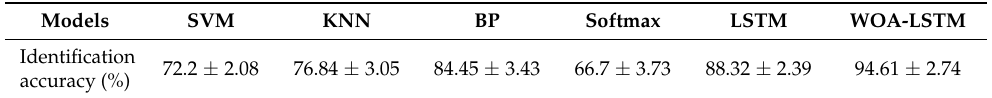
Table 8. Average identification accuracy of different gas identification models for multi-gas compo- nents with the full-sample selection